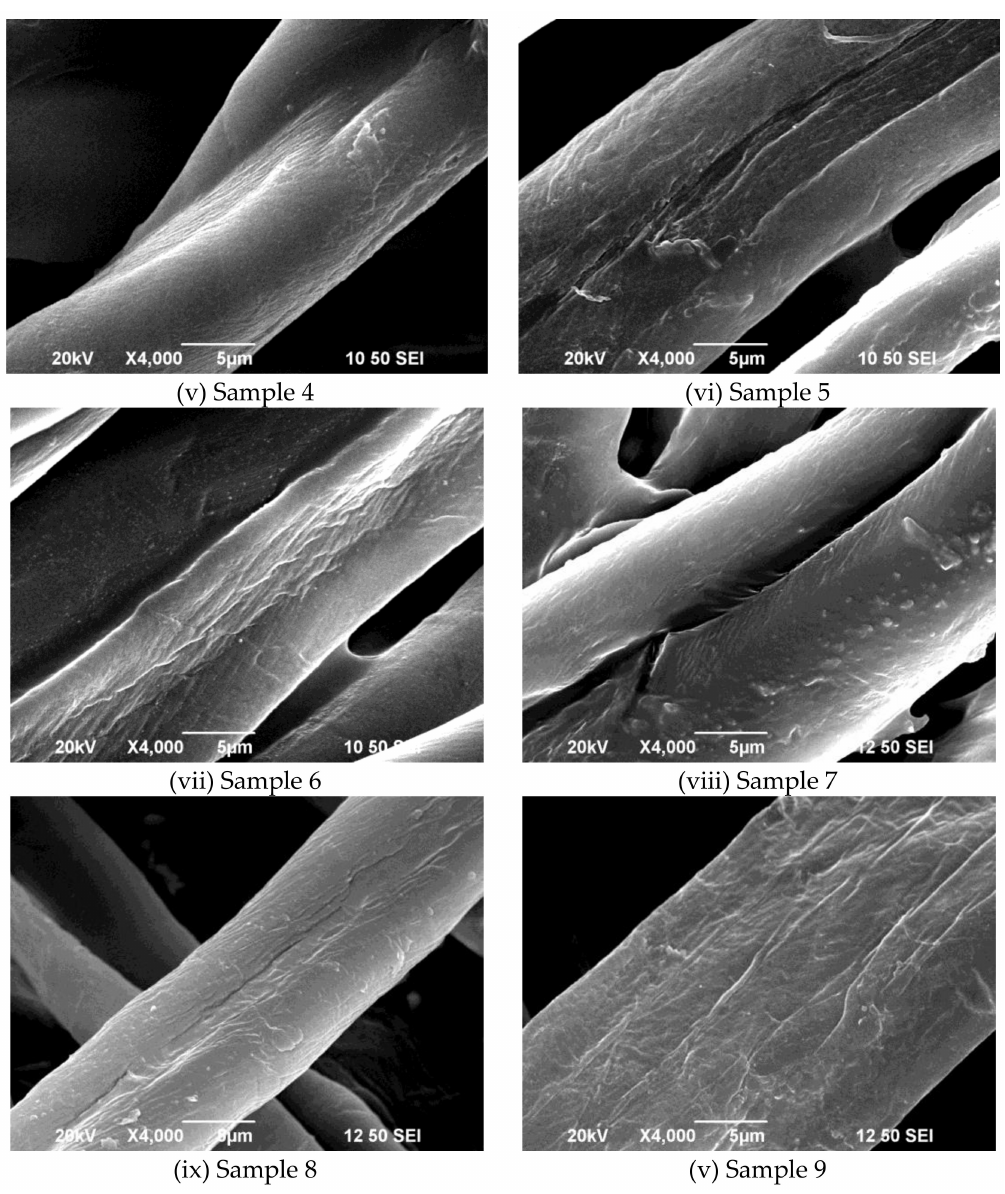
Figure 6. SEM images of 1 g/L pigment dyed samples treated with different atmospheric pressure plasma treatment